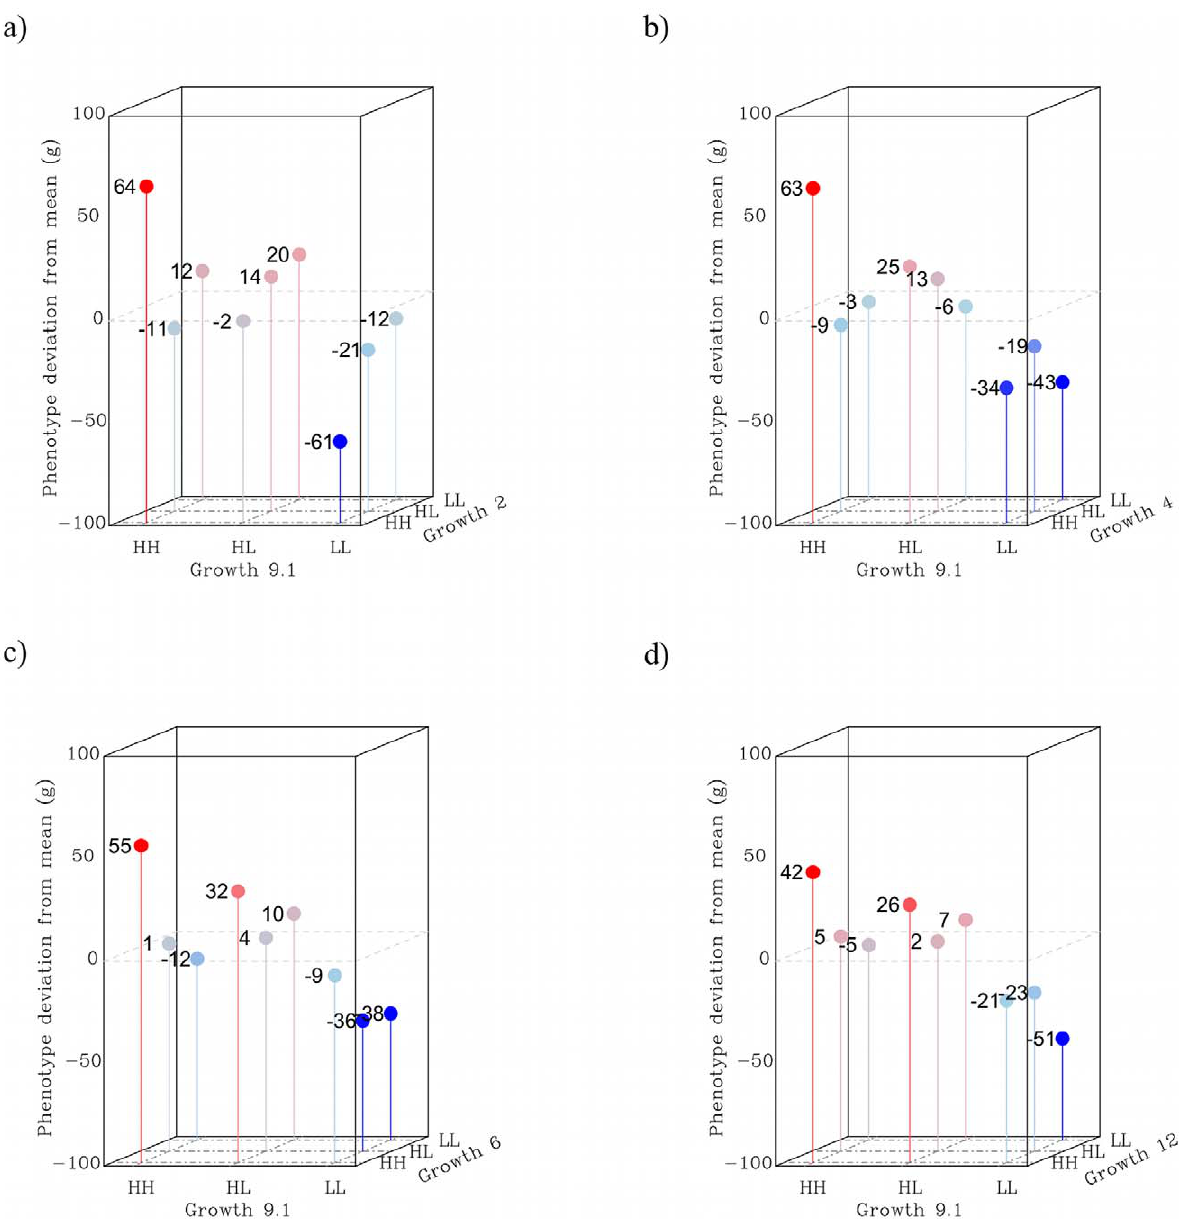
Figure 4. Two-way interactions in the radial QTL network. Panel a shows the interaction between Growth9.1 and Growth2 , where Growth2 on average has virtually no effect in this pedigree. However, stratification reveals that it has an effect, in opposite directions, in both the HH and LL background at Growth9.1 . The remaining panels show the synergistic interactions between HH-alleles in the three pairings between Growth9.1 and Growth4 ( b ), Growth6 ( c ) and Growth12 ( d ) in